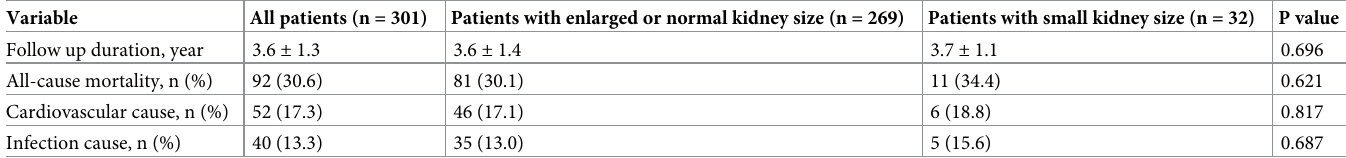
Table 4. Outcomes of diabetic patients receiving hemodialysis stratified by kidney size (n = 301).